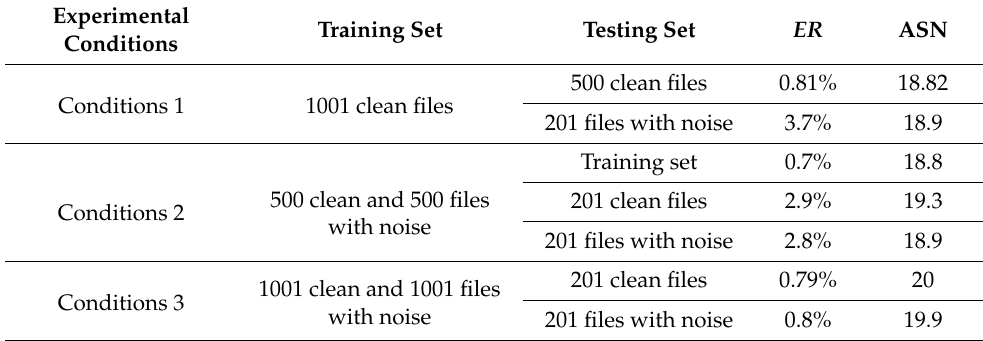
Table 3. The selection of the training dataset.